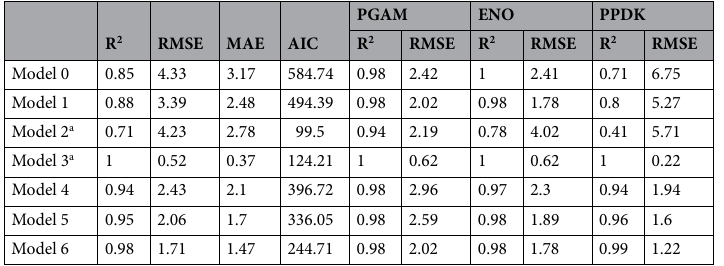
Table 6. Comparative table of statistical metrics of each model for the training set (Table S2). RMSE and MAE are in nmol·min −1 . a For these models, (cv)RMSE and (cv)R 2 are calculated.